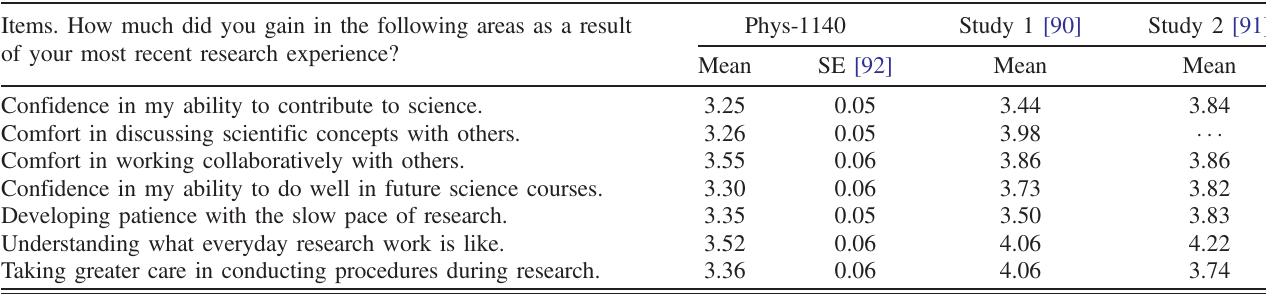
Confidence in my ability to do well in future science courses. Developing patience with the slow pace of research. Understanding what everyday research work is like. Taking greater care in conducting procedures during